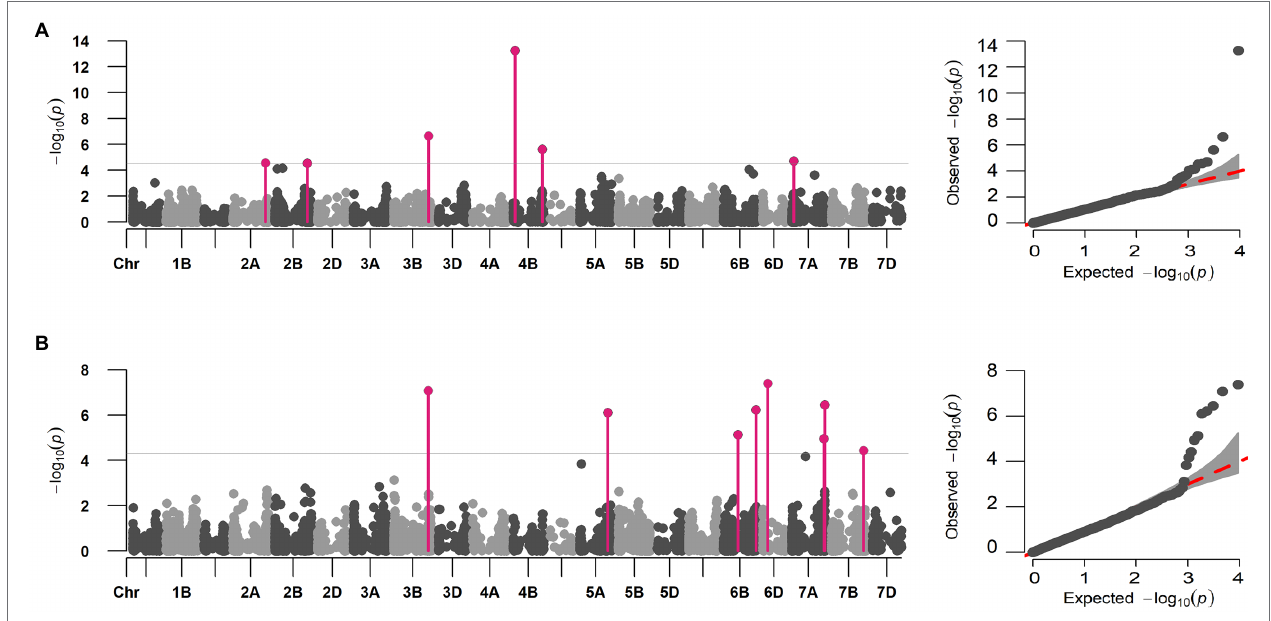
FIGURE 3 | Multi-locus marker-trait association for DIS and FDK in hard winter wheat breeding panel using the FarmCPU model. Manhattan and QQ plot for (A) DIS and (B) FDK showing the distinct peaks for identified MTAs. The significant associations (FDR p < 0.05) are elucidated using solid pink vertical lines.